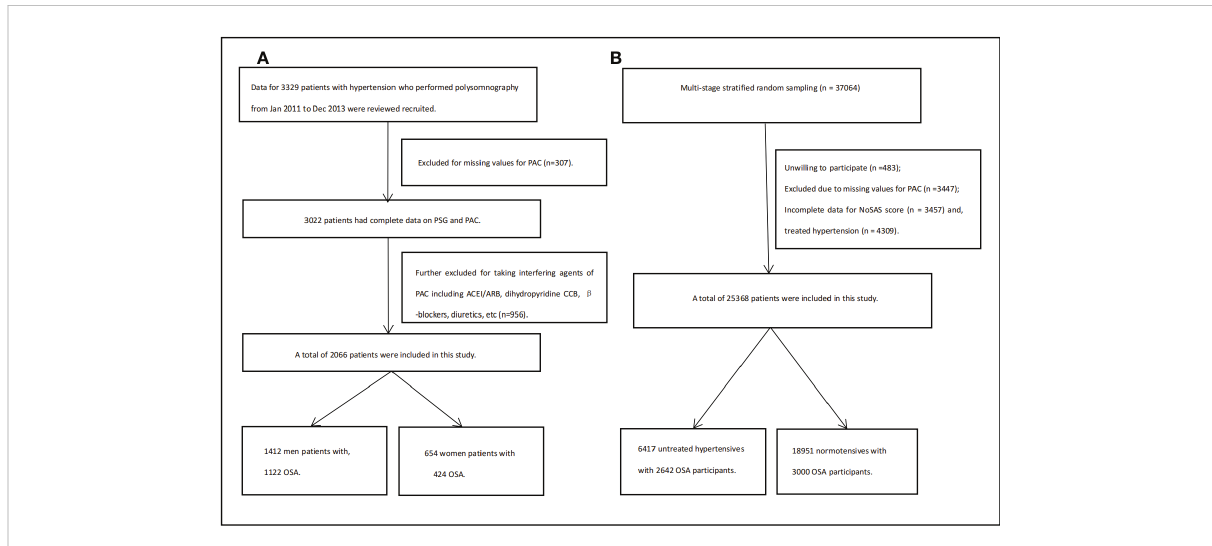
FIGURE 1 Flow chart for clinical participants (A) and for general population (B)